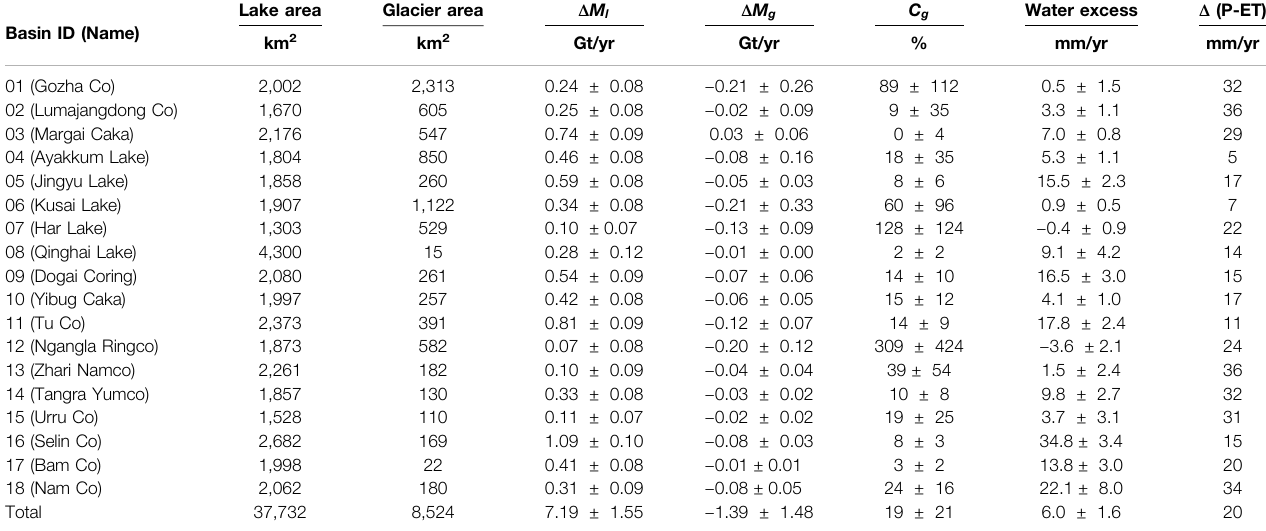
TABLE 1 | Summary of basin characteristics and